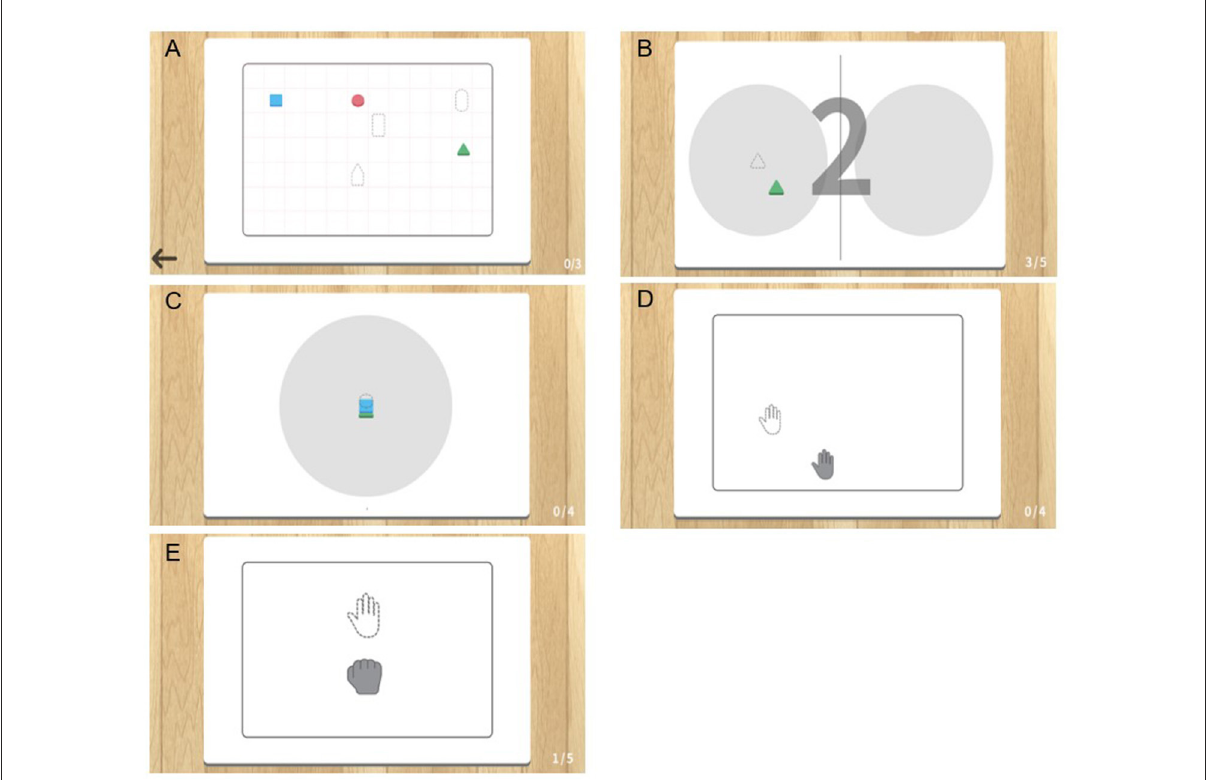
FIGURE2 Illustration of five gamified programs included in the mixed reality (MR)-board. (A) Matching the same shape. (B) Moving the object. (C) Stacking the objects. (D) Placing the arm. (E) Grasp and release.